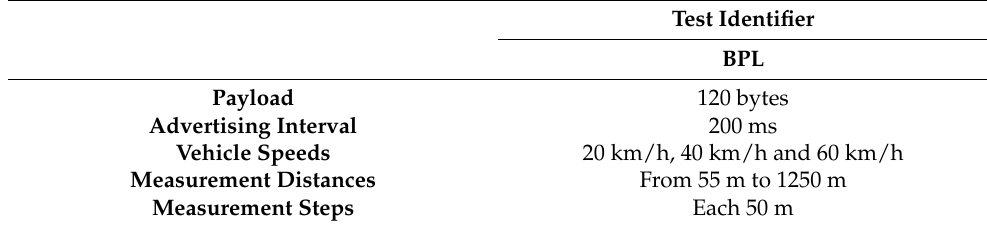
Table 5. Test configuration Dynamic I2V